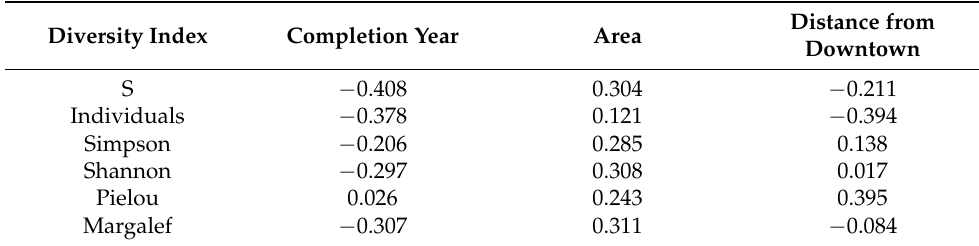
Figure 6. The Shannon, Simpson, Margalef, and Pielou indices for tree species diversity in the three groups of resettlement residential areas in Changzhou. Table 3. Pearson’s correlation among tree species diversity indices and three attributes of resettlement residential area in